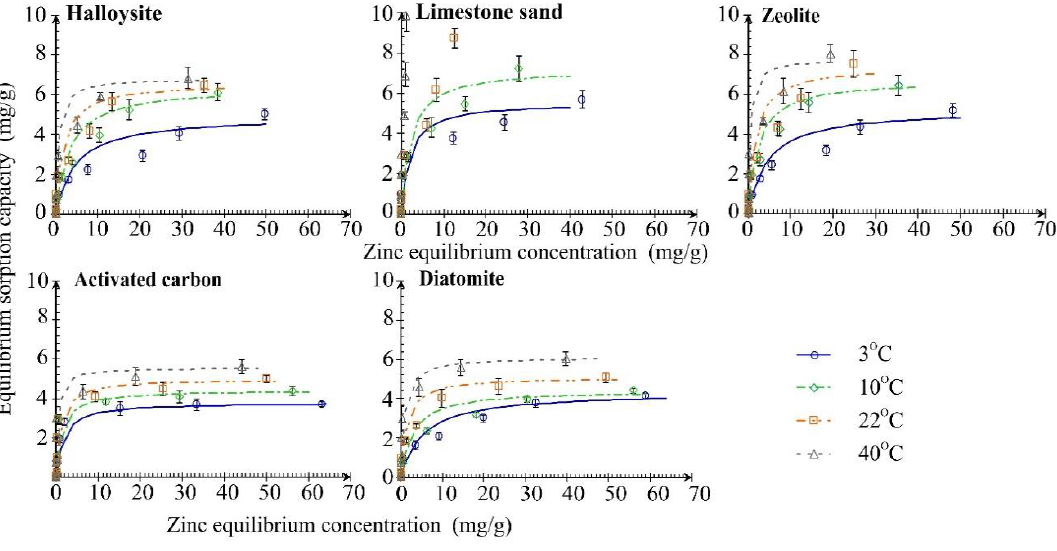
Figure 5. Adsorption isotherm of zinc ions (error bars mark the standard deviation for n = 3; line - fitting of Langmuir isotherm).